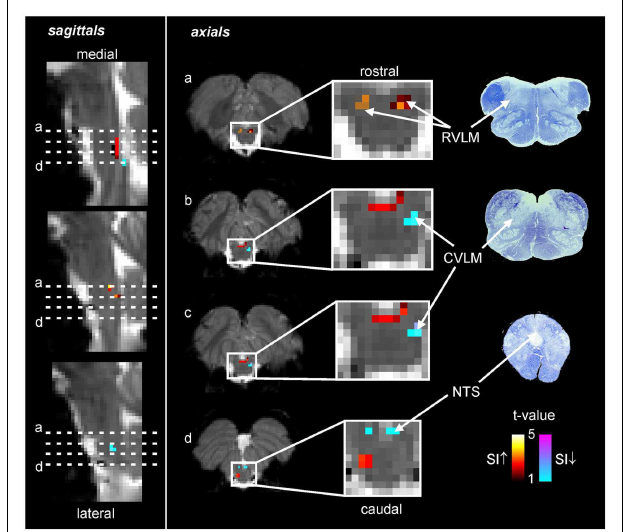
FIGURE 5 | Functional magnetic resonance imaging (fMRI) signal intensity changes correlated to spontaneous fluctuations in muscle sympathetic nerve activity (MSNA) in eight subjects . Increases in signal intensity with increases in MSNA are coded by the hot color scale and signal decreases with the cool color scale and are overlaid onto a series of sagittal and axial fMRI slices from an individual subject. Myelin stained sections through the medulla are shown to the right. CVLM, caudal ventrolateral medulla; NTS, nucleus tractus solitaries; RVLM, rostral ventrolateral medulla; SI, signal